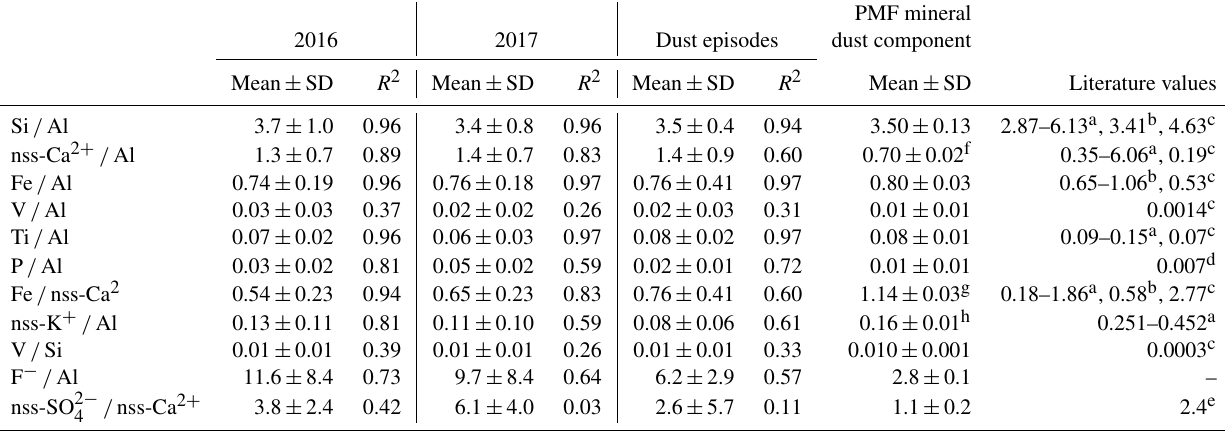
Table 3. Annual arithmetic mean mass ratios of mineral dust tracers with respect to Al for 2016 and 2017. The Pearson coefficient of the linear regression ( R 2 ) is reported. Mass ratios for previous publications are shown for comparison. Standard deviations are indicated as